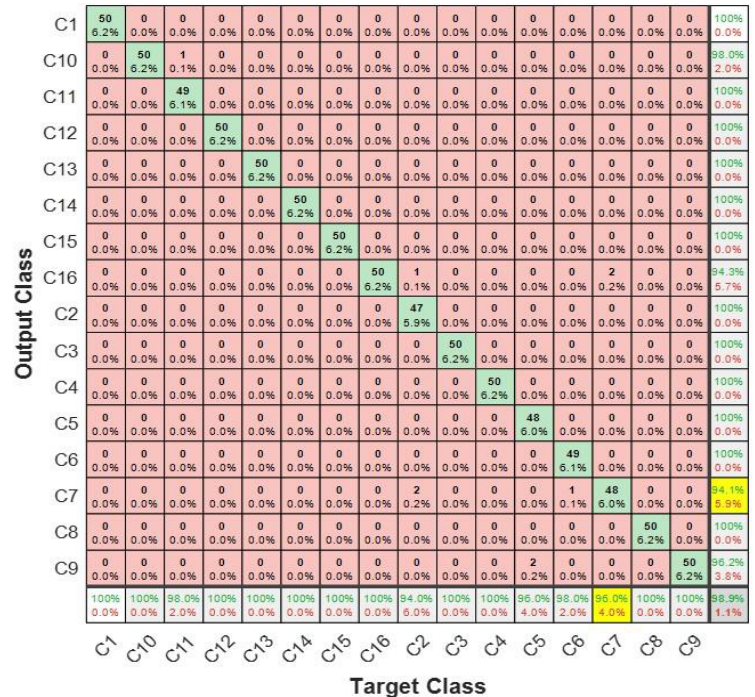
Figure 13. Confusion matrix for the proposed ensemble model implementation.